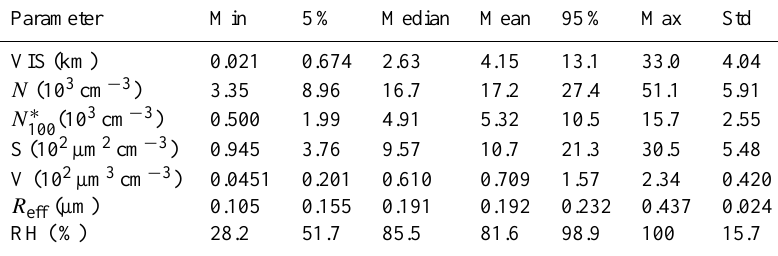
Table 2. Characteristics of VIS, N , S, V, R eff and RH.